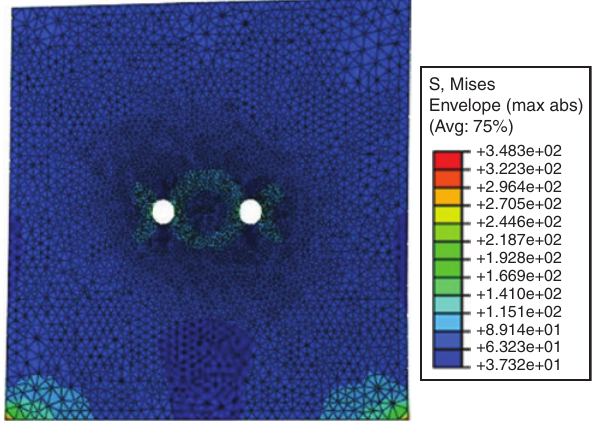
Figure 4: Curve (outline). Defined for J integral around a notch in two dimensions.